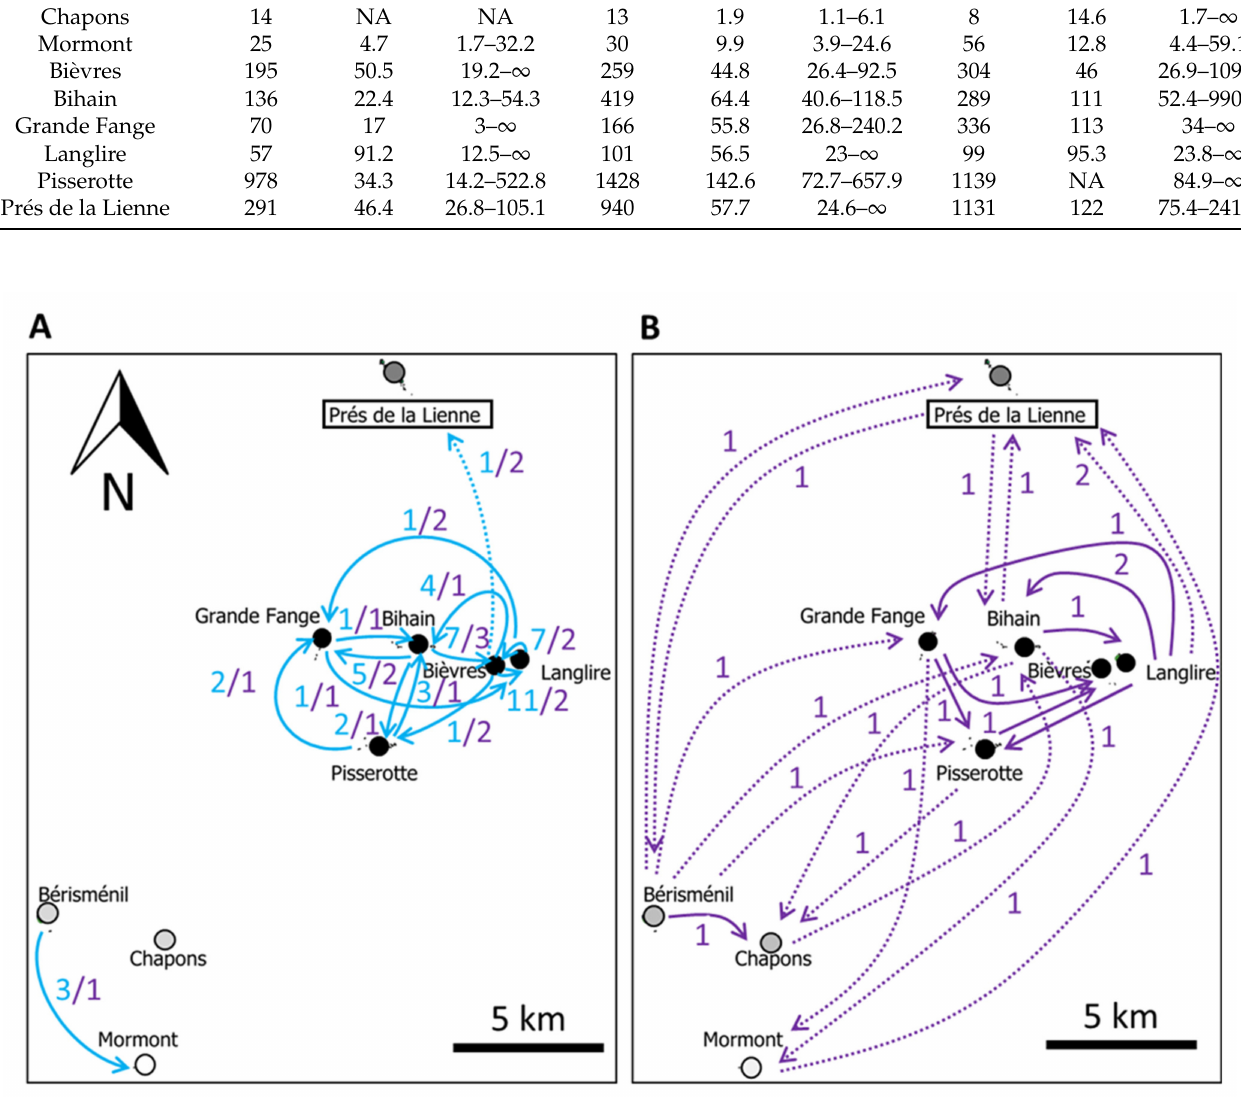
Figure 2. Contemporary dispersal movements from demographic (blue arrows) and genetic (purple arrows) data cumu- lated over the three sampling years. ( A ) movements directly recorded in the field via Capture-Mark-Recapture (blue), complemented by the number of first-generation effective movements inferred from genetic data (purple) for the same pairs of populations. ( B ) All the other movements inferred from genetic data for other pairs of patches, separated to gain in map clarity. Long-distance movements are symbolized by dashed